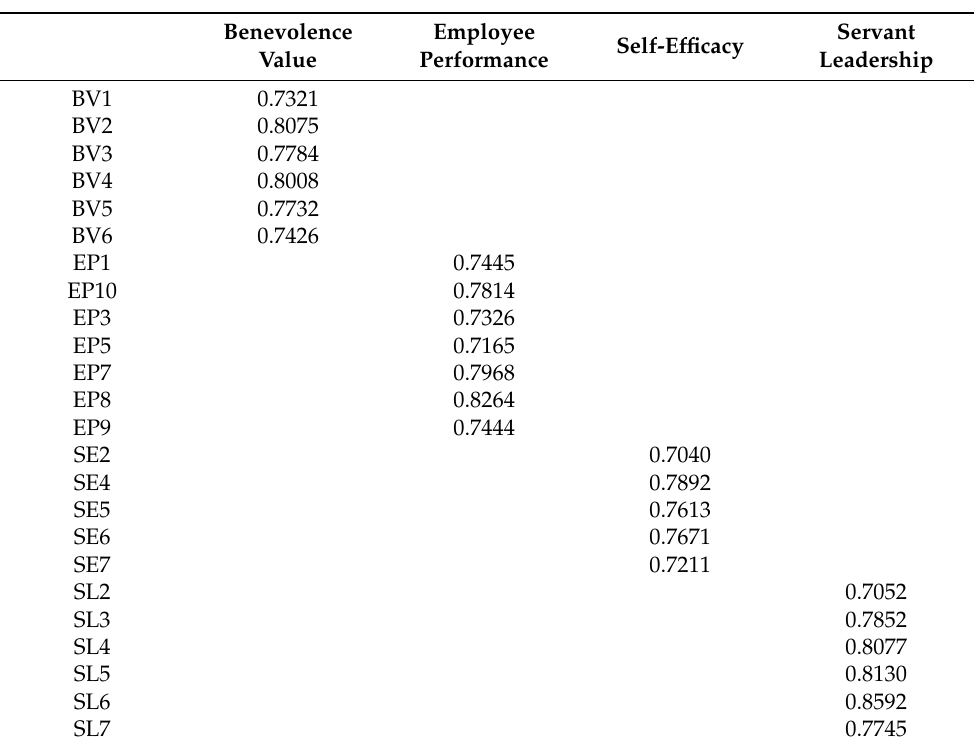
Table 3. Cross-loadings.